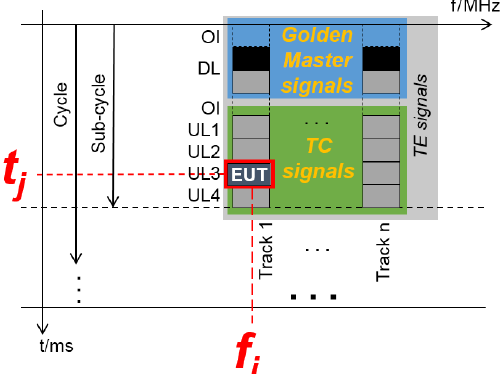
Figure 10. A device as EUT: the signals from the TE (Test Equip- ment, light-gray) involve signals from the Golden Master (light- blue) and the TC (Test Companion, green), which are the emulated signals from additional devices.